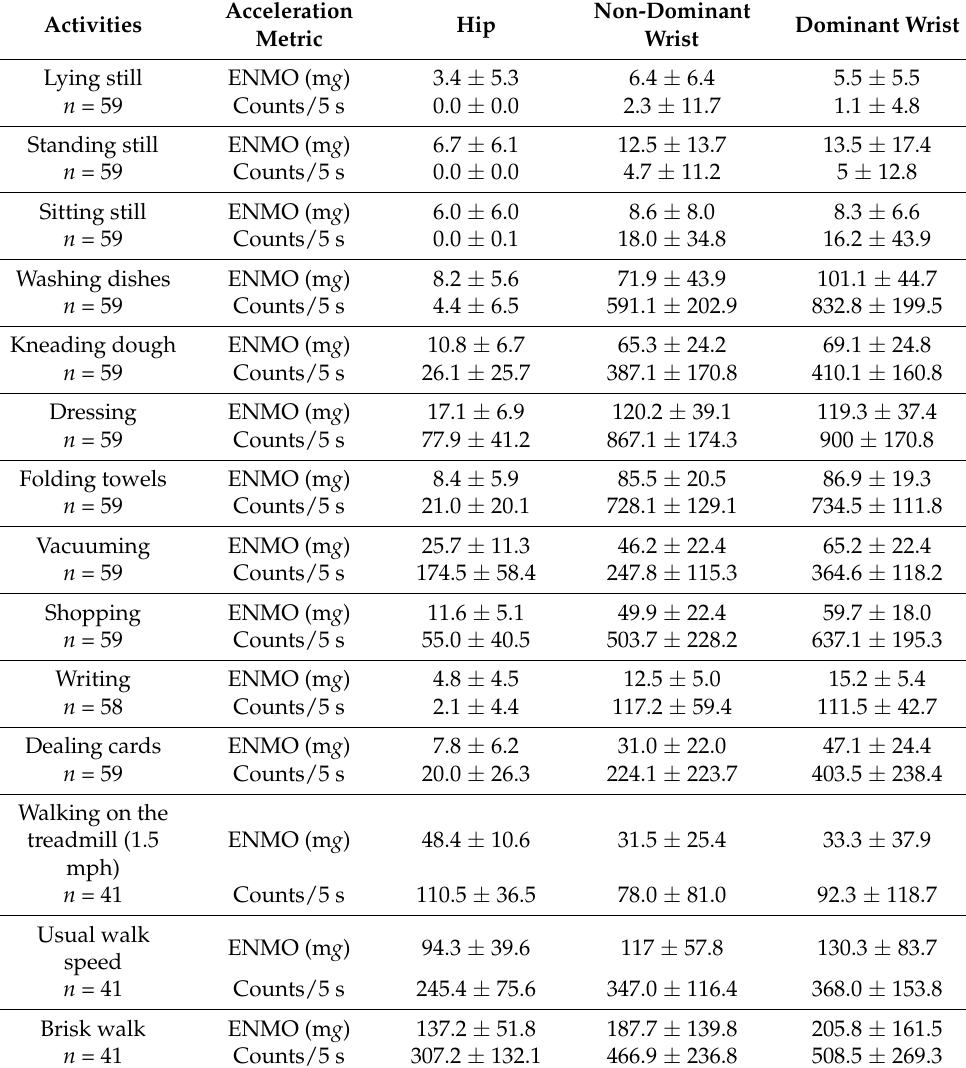
Table 3. Accelerations values during each laboratory activity in the calibration sample